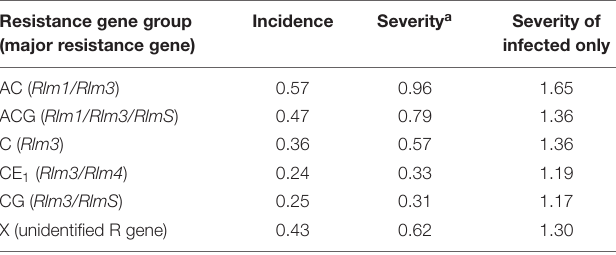
TABLE 4 | Blackleg disease incidence, severity, and severity of only infected plants from field sites in Manitoba, Saskatchewan, and Alberta in 2018 and 2019 based on cultivars’ major resistance gene